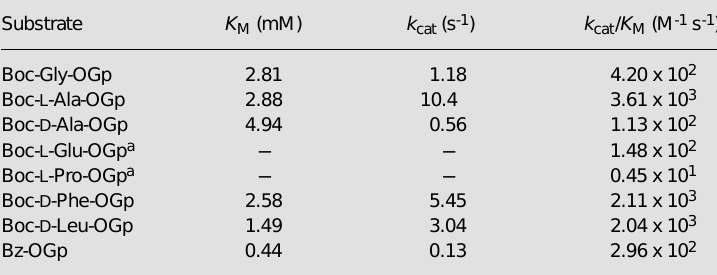
Table 5 - Steady-state kinetic parameters for the chymotrypsin-catalyzed hydrolysis of 4-guanidinophenyl esters (Günther R, Thust S, Hofmann H-J and Bordusa F, unpub- lished